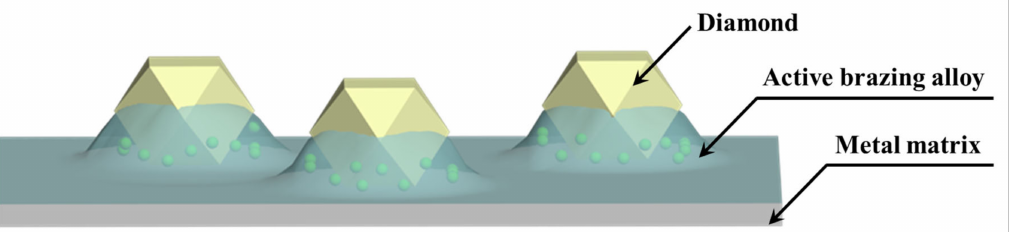
Figure 2. The diagram of the brazed diamond